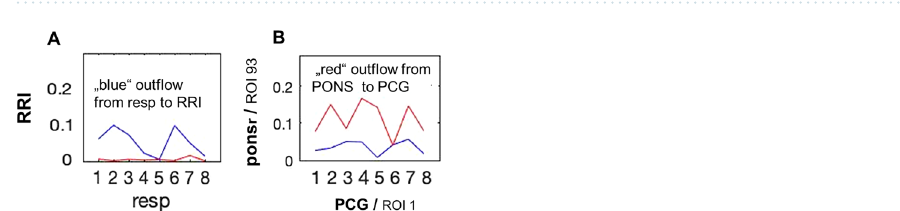
Figure 2. Estimated by means of ffDTF( f ) information transmissions depending on time and frequency between the 6 channels for an exemplary participant. The transmission of information is from the signal marked below the column to the signal marked at the left. In each box, the ffDTF( f ) function for eight 40-s long epochs (windows) is shown; x -axis: time in seconds, y -axis: frequency from 0 to 0.5 Hz. Colors reflect the amplitude size of ffDTF (red indicates the strongest transmission).